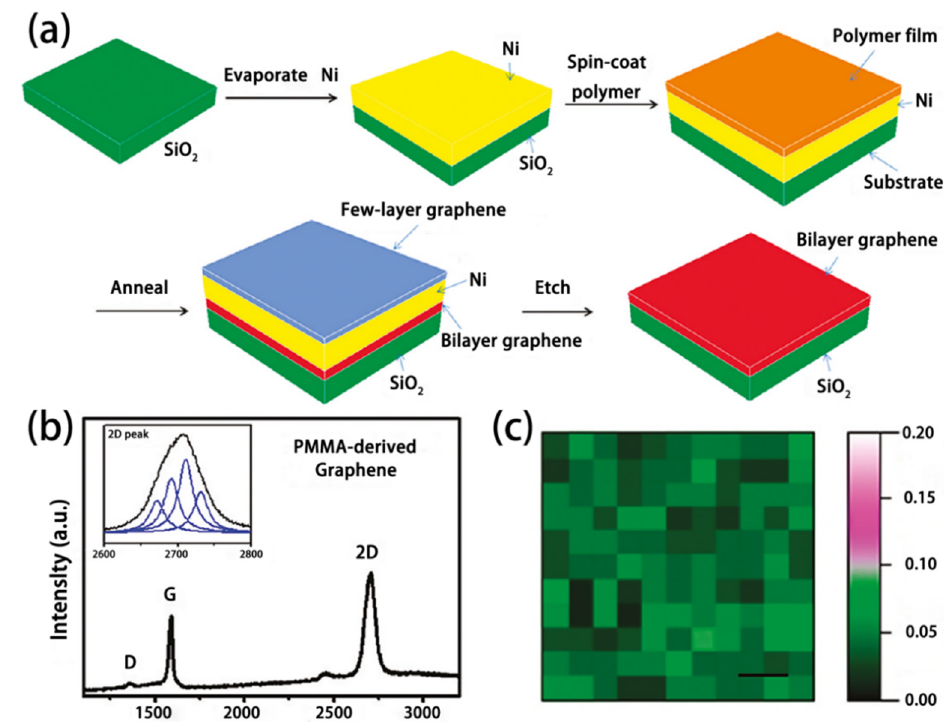
Figure 4. Graphene growth from solid carbon sources. ( a ) growth process; ( b ) Typical Raman spectra of PMMA-derived bilayer graphene; ( c ) D/G peak ratio mapping in area of 100 × 100 µ m 2 for PMMA-derived bilayer graphene [37].